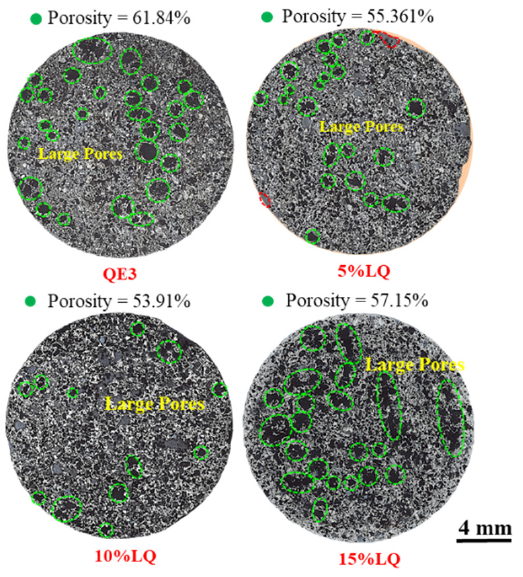
Figure 17. Panorama of ferro-coke on cross-section with different amounts of coal-tar pitch.